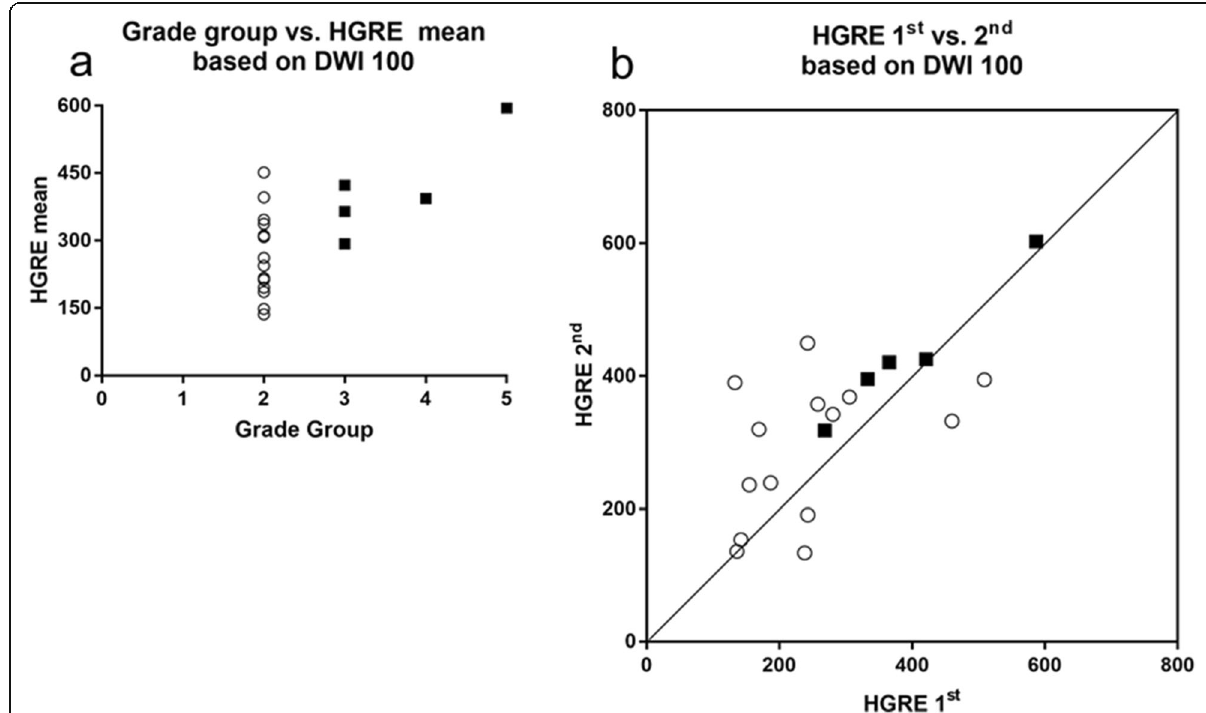
Fig. 6 Transition zone cancer. a Correlation between grade group and mean of the first and second high gray-level run emphasis of gray-level run-length matrix based on diffusion-weighted (DWI) 100. b XY plot of the first and second high gray-level run emphasis of gray-level run-length matrix based on DWI 100. Open circle, closed square, and line indicate grade group (GG) of 1 and 2, GG of 3, 4, and 5, and Y = X line,